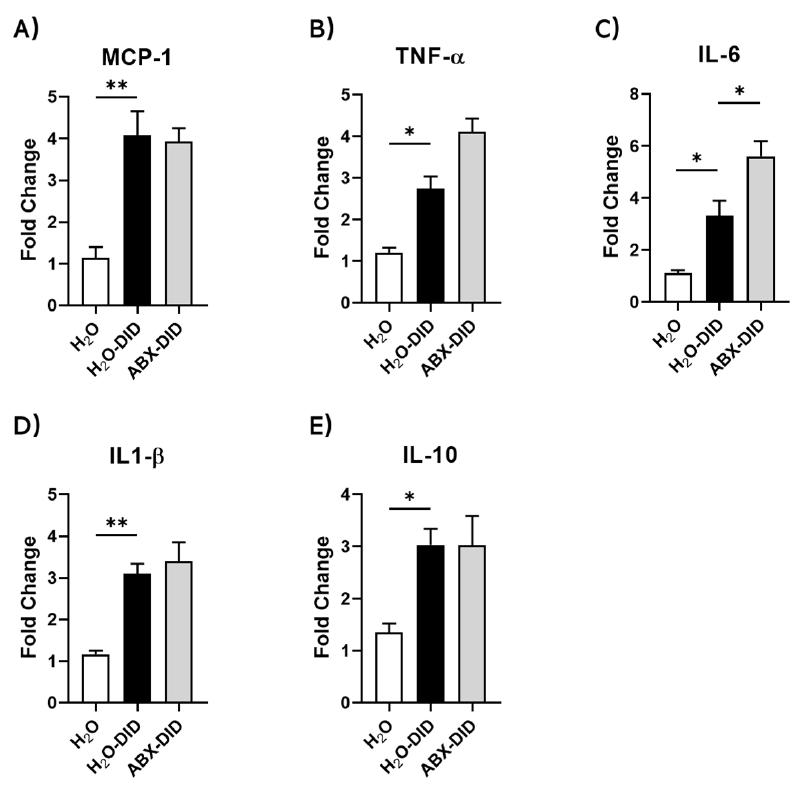
Figure 1. The effects of ABX treatment on mRNA levels of pro- and anti-inflammatory cytokines in mouse brains within the DID model. Ethanol (20%) consumption during the DID procedure induced increases in the mRNA levels of both pro-inflammatory MCP-1, TNF- α , IL-6, IL-1 β ( A – D ) and anti-inflammatory IL-10 ( E ) cytokines. ABX treatment starting 2 weeks before and continued throughout the DID procedure enhanced mRNA levels of TNF- α and IL-6 and did not affect mRNA levels of MCP-1, IL-1 β and IL-10, induced by ethanol. mRNA levels were assessed by real-time RT-qPCR. Data are presented as Mean ± SEM, n = 7–9/group. * p < 0.5, ** p < 0.01, Ordinary one-way ANOVA with Tukey multiple comparisons.